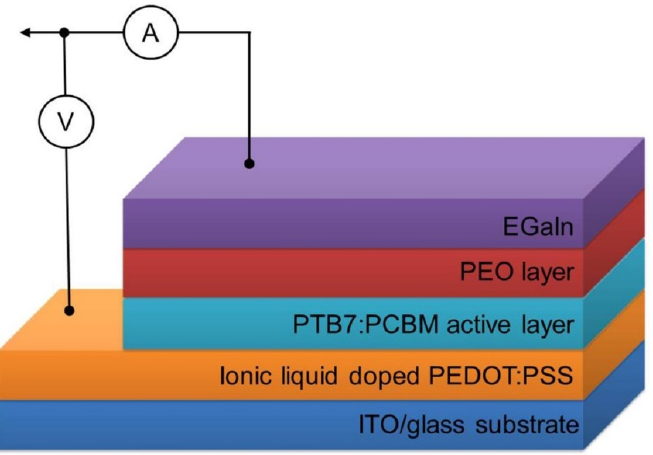
Figure 2. Cross-section view of PTB7:PCBM organic solar cells with ionic-liquid-doped PEDOT:PSS as the hole-transport layer and liquid EGaIn anode. Device structure of ITO/pHN-PEDOT:PSS/PTB7:PCBM/PEO/EGaIn was fabricated.